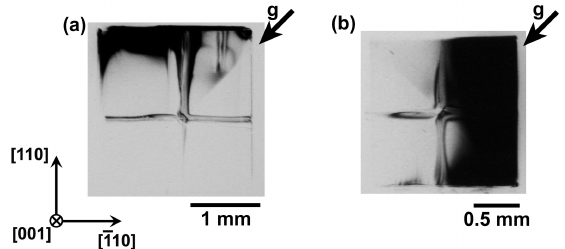
Figure 6. Synchrotron monochromatic-beam X-ray topographs of tetragonal HEW lysozyme crystals prepared ( a ) without and ( b ) with an applied field at 1 MHz taken using the 0¯40 reflection with the incident beam almost parallel to the [001] crystallographic